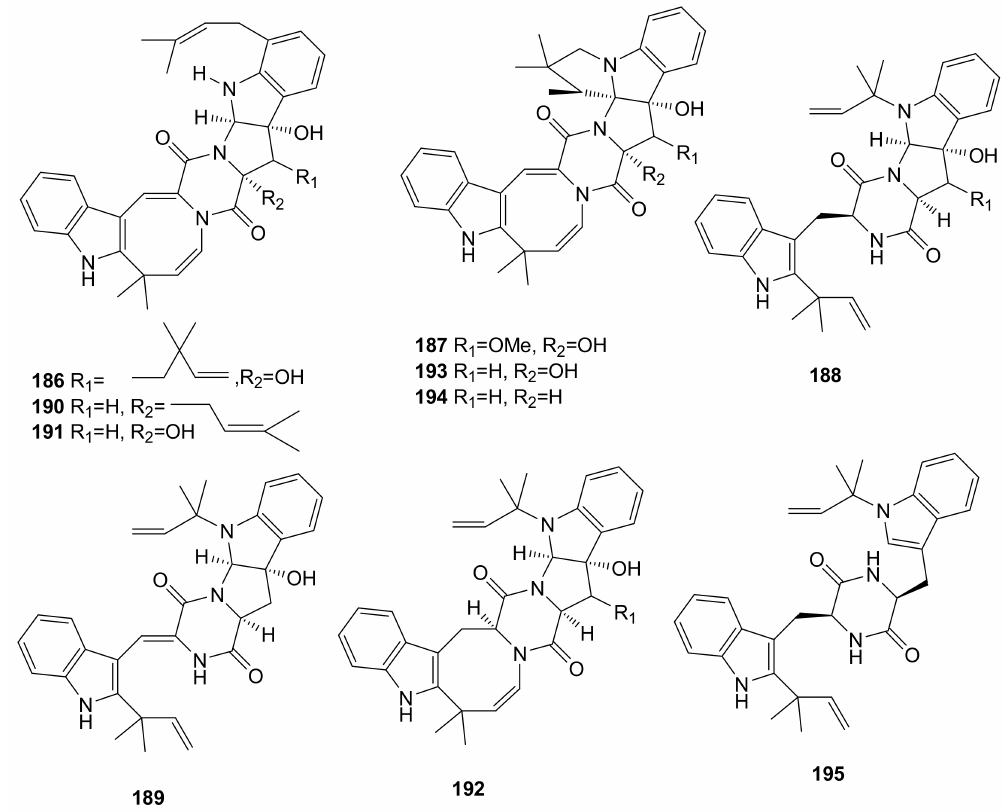
Figure 13. The structures of okaramines A, B, C, G, H, I, N, and Q ( 186 – 193 ); 2-Dehydroxy-3-demethoxy okaramine B ( 194 ); and cyclo( N 8 -( α , α -dimethylallyl)- L -Trp-6a (cid:48) -( α , α -dimethylallyl)- L -Trp) ( 195